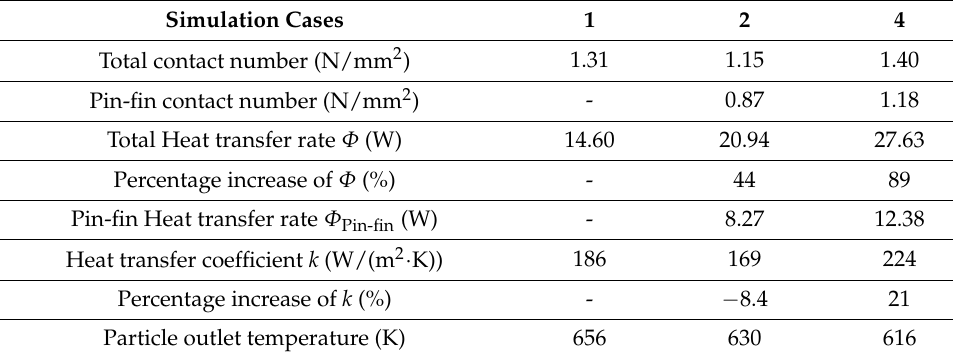
Table 4. Heat transfer characteristics for different